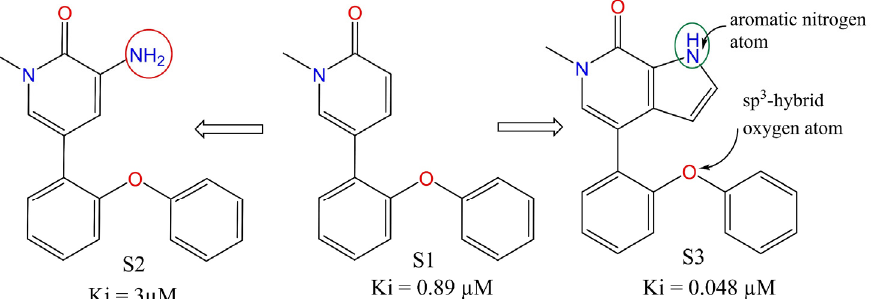
Figure 7. Effect of fsp3OaroN6B on BRD-4 inhibitory activity.